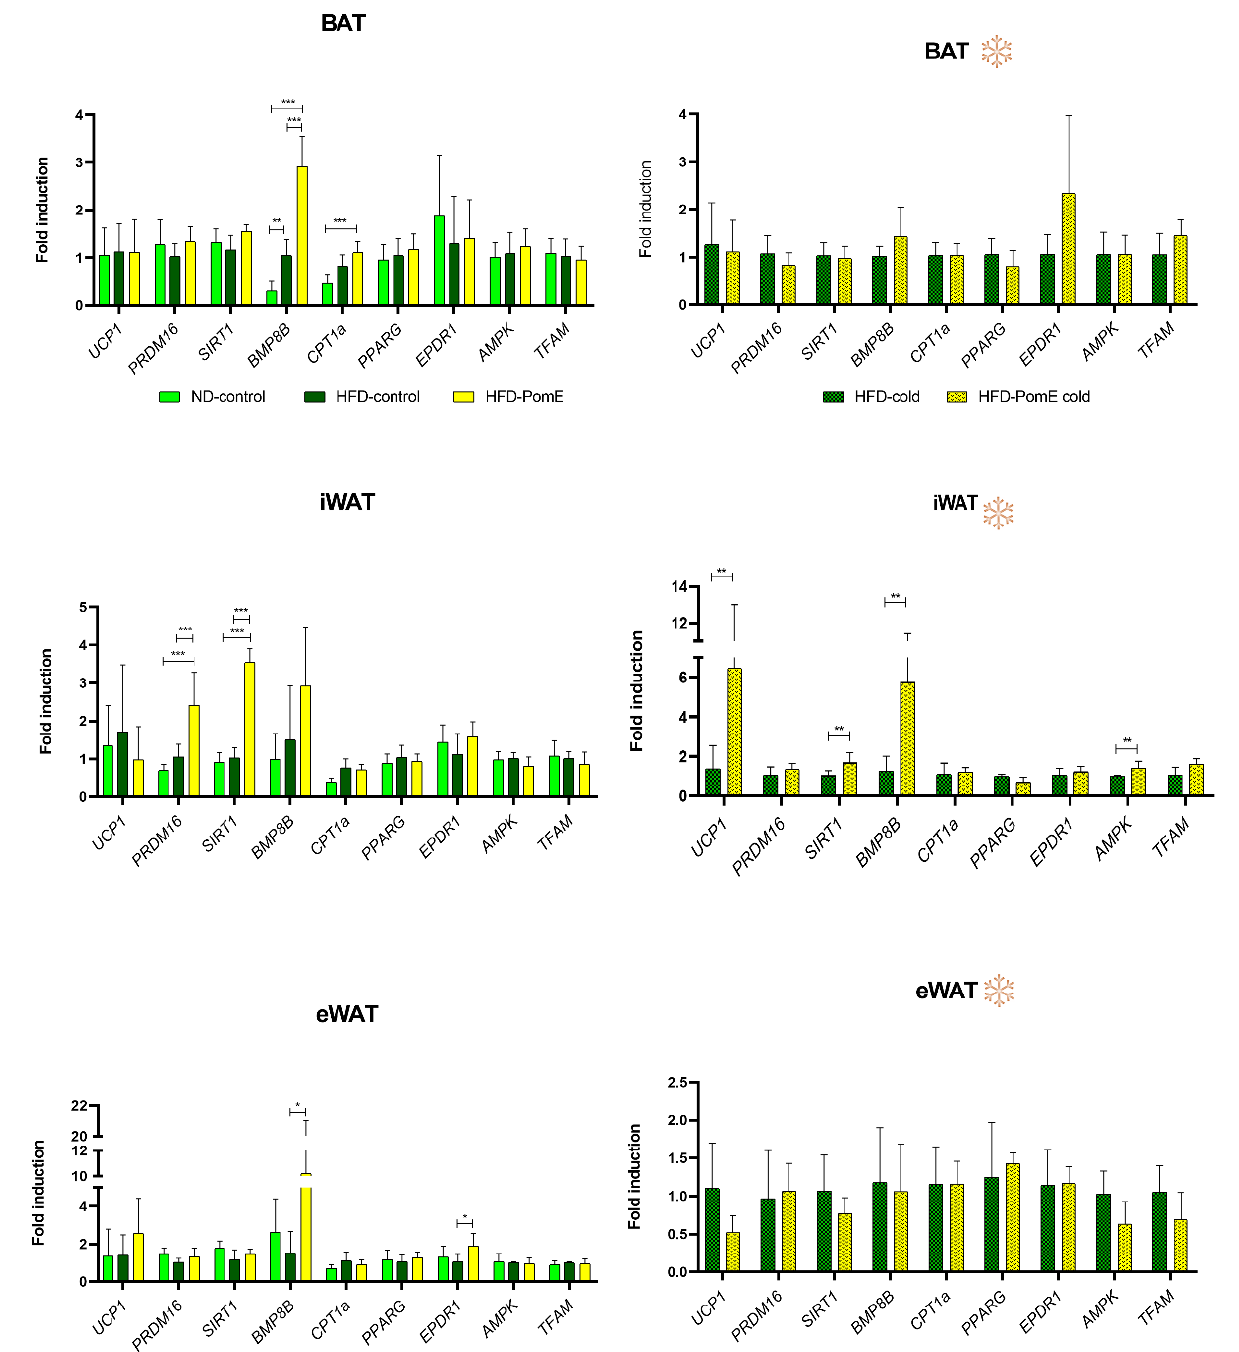
Figure 6. Gene expression levels of targets related to thermogenesis in the different types of adipose tissues (brown (BAT), inguinal white (iWAT), and epididymal white (eWAT) adipose tissues), in ND, HFD-control and HFD-PomE groups, exposed or not to cold stress (N = 4–8). Statistically significant values are indicated with asterisks based on their p- value, * p < 0.05, ** p < 0.01, *** p < 0.001.